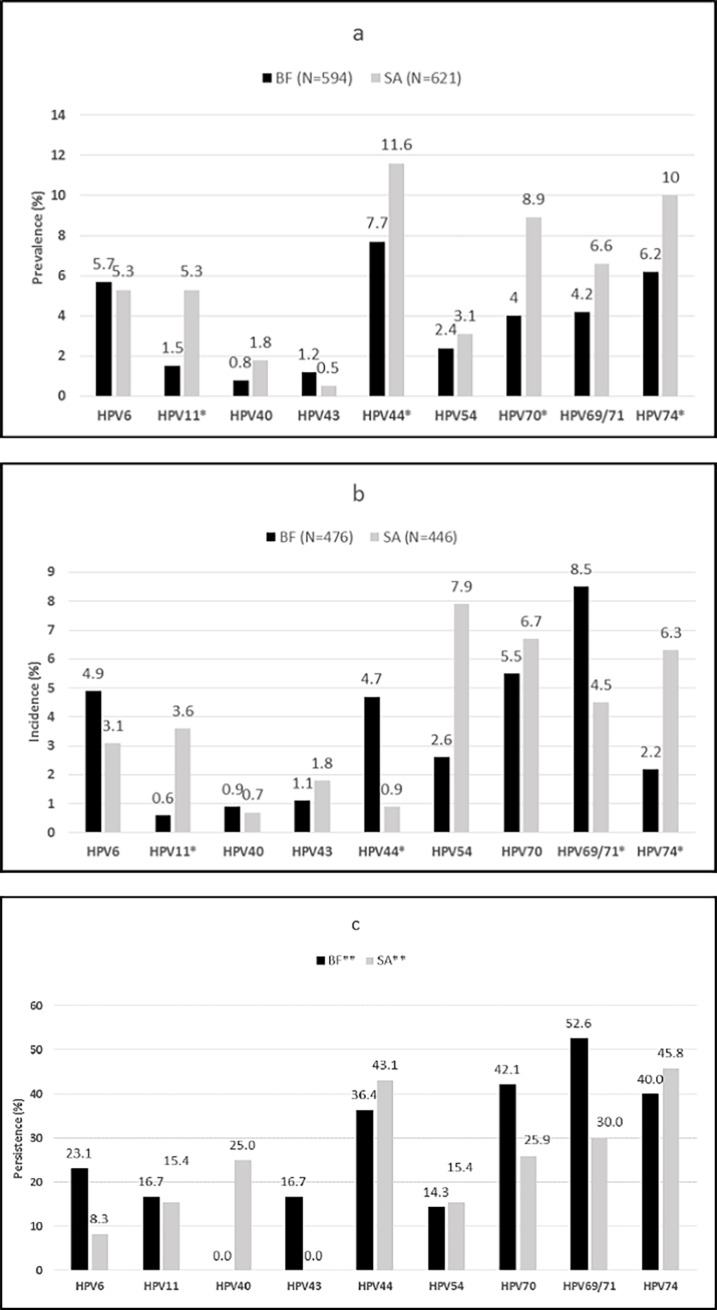
Type specific LR-HPV infection.(A) Prevalence at enrolment. (B) Incidence over 16 months. (C) Persistence over 16 months. *Significantly different between the two countries (i.e. p-value <0.05). **Persistence as a proportion of those positive for that specific type at enrolment.